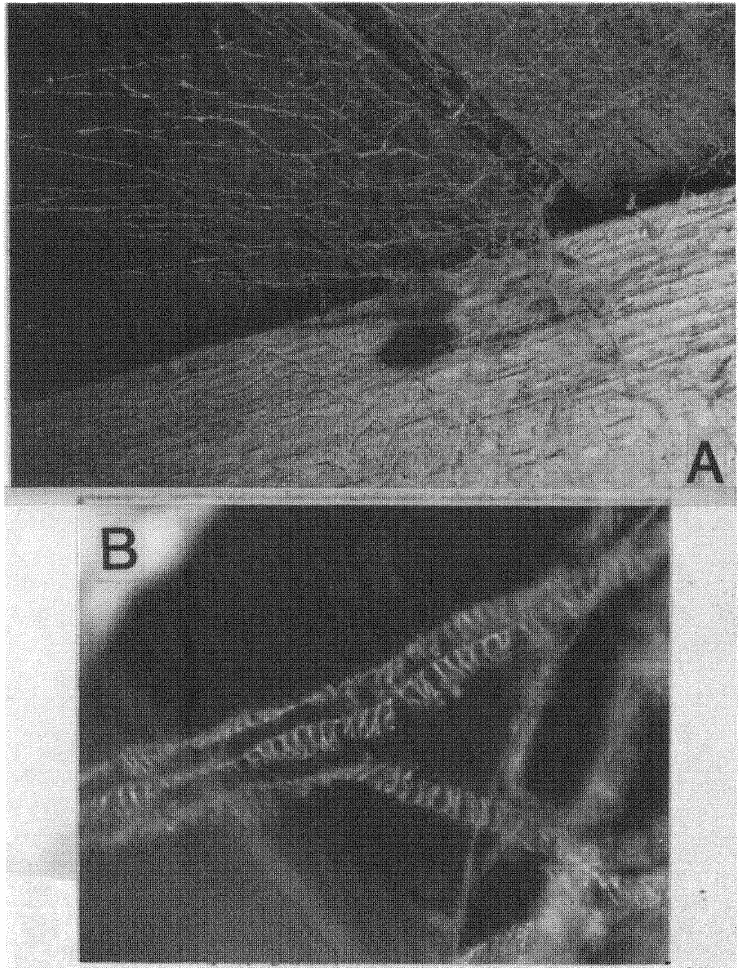
Fig. 2. A, web of F. hibernalis with cocoon of A. azureus, site is open shed; B, web of F. hibernalis, showing loops of Hackled